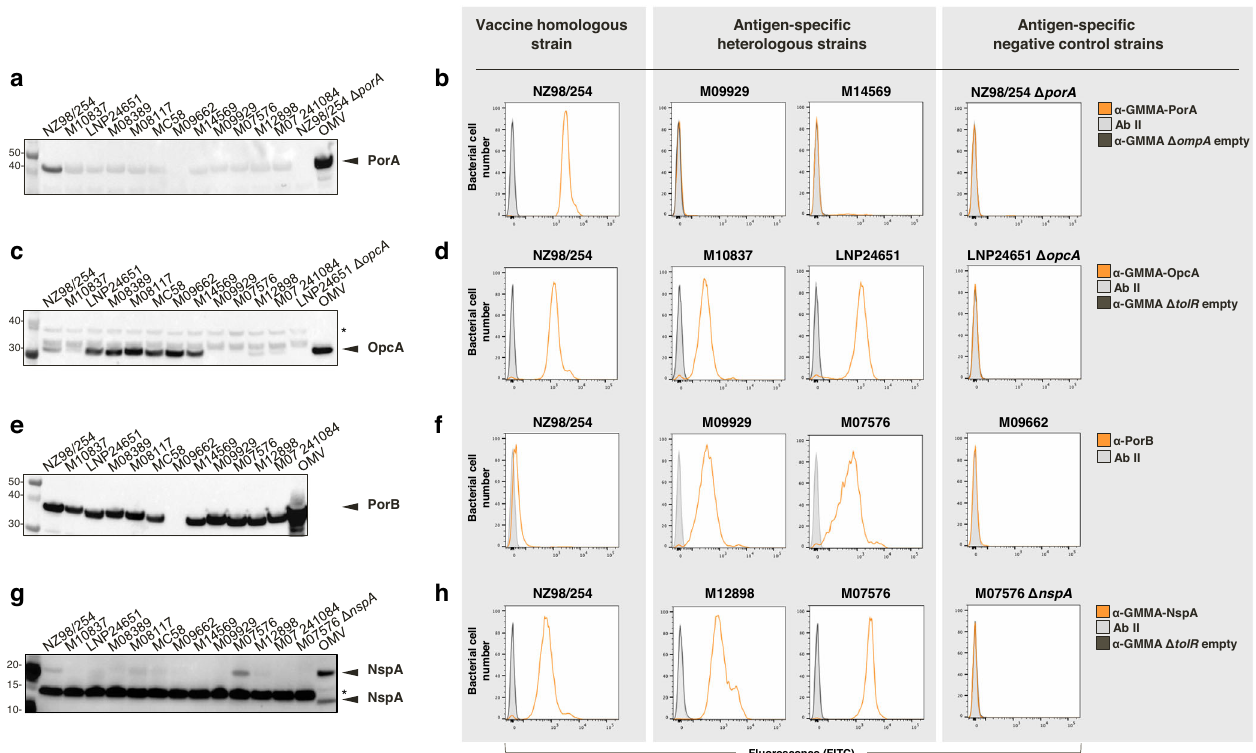
Fig. 4 Evaluation of the expression levels and surface-localization of PorA, OpcA, PorB, and NspA in the panel of OMV-speci fi c strains. OMV and meningococcal crude lysates, prepared from bacteria culture grown in SBA-like conditions, were resolved in SDS-PAGE prior to western blotting and probing with GMMA-PorA ( a ), GMMA-OpcA ( c ), rPorB ( e ), and GMMA-NspA ( g ) sera. Speci fi c bands are indicated by arrows. Asterisk refers to the unspeci fi c band used as loading control among strain lysates. The binding of polyclonal antisera raised by PorA ( b ), OpcA ( d ), PorB ( f ), and NspA ( h ) antigens was assessed by fl ow cytometry against four MenB strains (the vaccine strain NZ98/254, two representative heterologous strains for each antigen and the speci fi c negative control strain). The whole panel of strains assayed in FACS surface staining is represented in Supplementary Fig. 8. Shaded gray pro fi les represent bacterial cells exclusively stained with secondary antibodies, while non-shaded dark gray pro fi les indicate sera raised against GMMA empty Δ tolR and Δ ompA (negative controls). Non-shaded orange pro fi les show the reaction with speci fi c immune sera. Ab II secondary antibody. The uncropped and unprocessed scans are reported in Supplementary Fig.